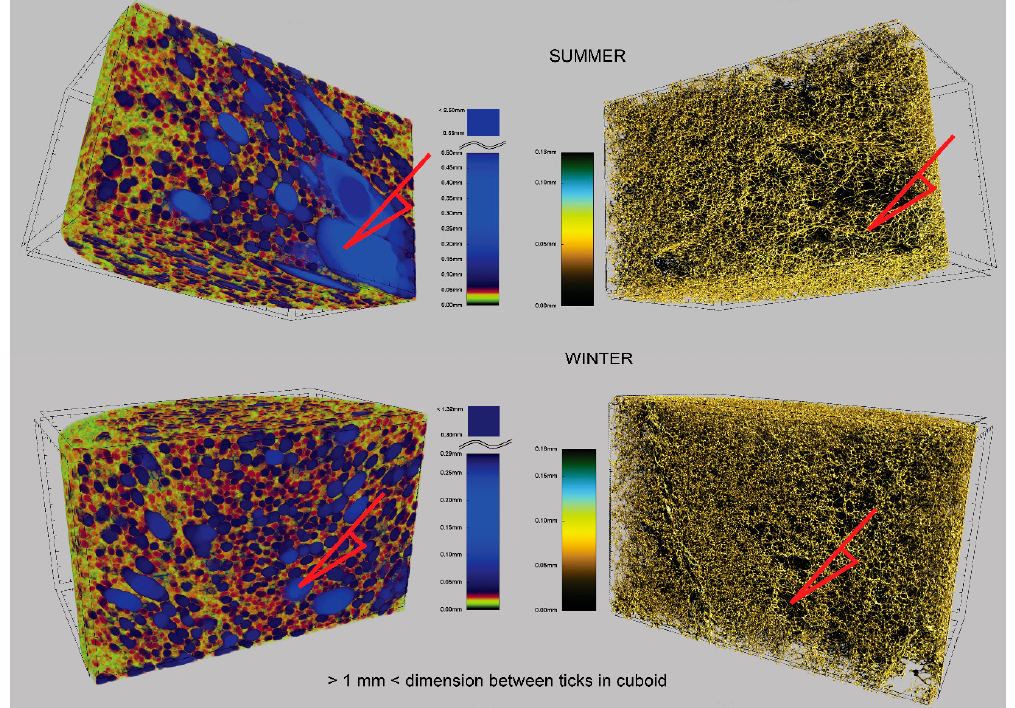
Figure 6. The S ‐ and W ‐ foams 3D realistic visualization screens (image pixel size 25 µm)—mapping the pore system (left) and matrix skeletal frame (right). The scales assign colors to the given pore size and strut thickness. The red arrows point corresponding regions on the pore map and the strut map; they are also to show visible difference in pore size comparing the W ‐ with S ‐ foam (SUMMER/WINTER).